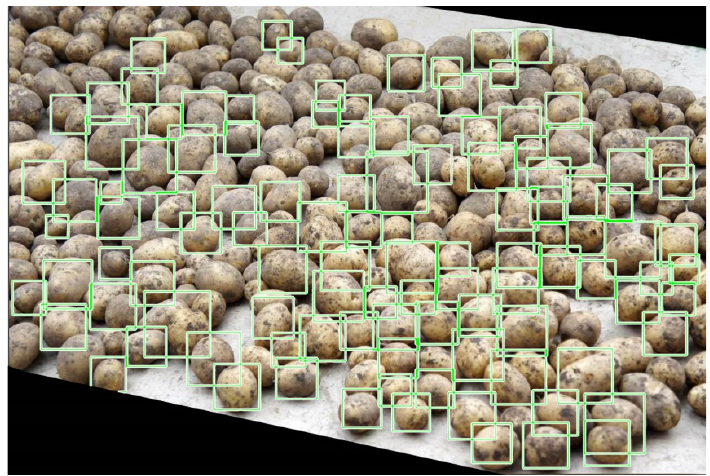
Figure 8. Identification of potato tubers by the Viola-Jones method.